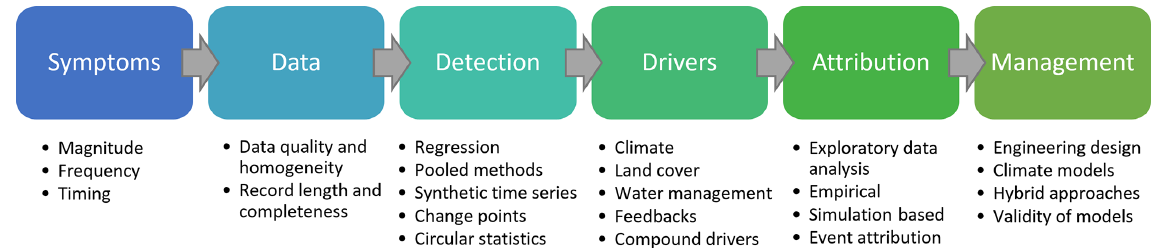
Figure 2. Workflow for the detection, attribution, and management of nonstationary hydroclimatic extremes. Bullet points indicate examples discussed in the paper (Sects.